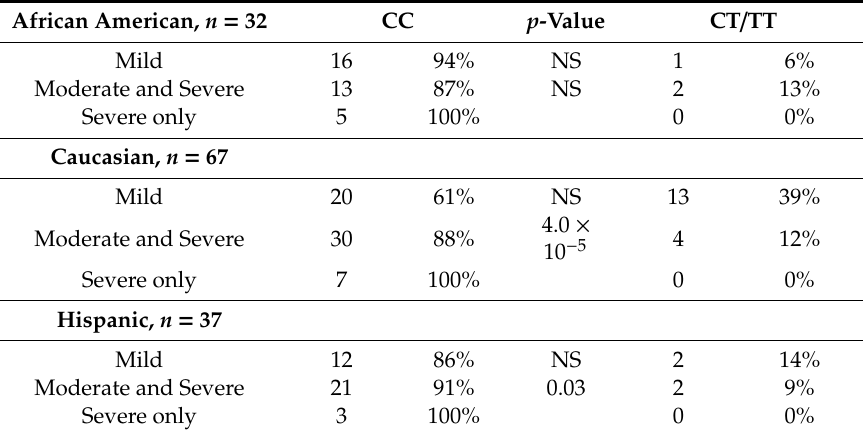
Table 4. Distribution of rs1001179 by race and disease